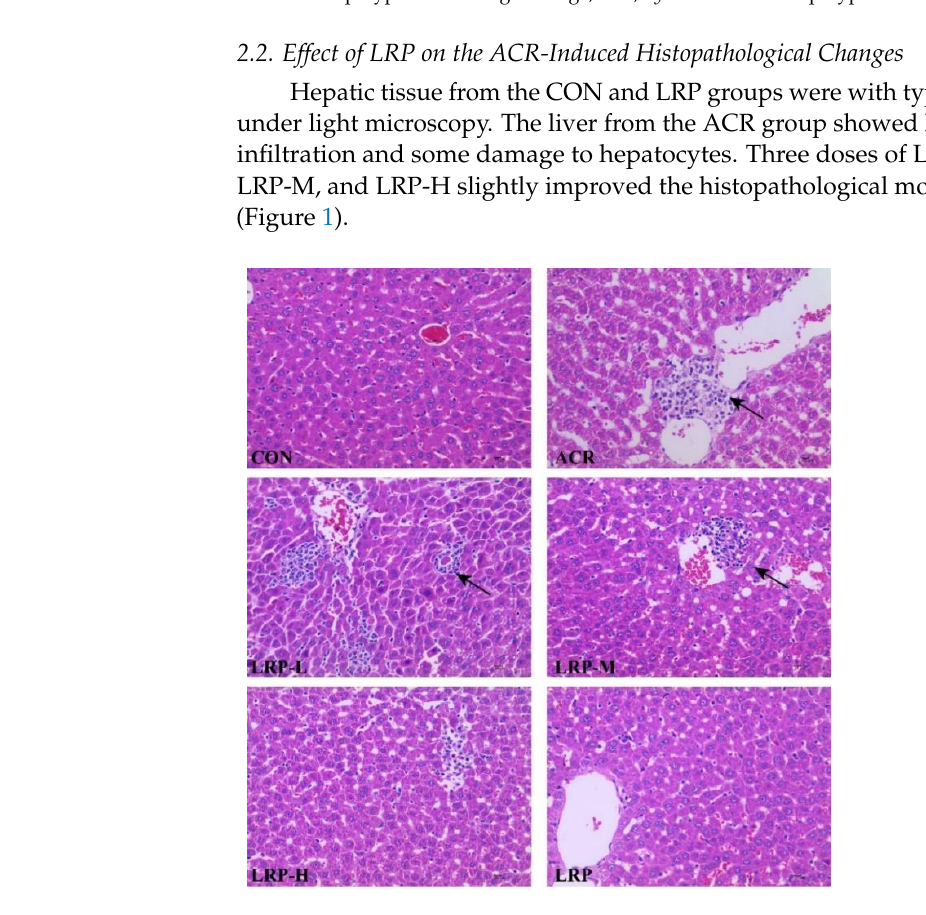
Figure 1. Effect of LRP on the ACR-induced histopathological changes (hematoxylin and eosin (H&E), 400×, bar 10 μm). The black arrow, inflammatory cell infiltration. ACR, acrylamide; LRP-L, Lycium ruthenicum polyphenols in low dosage; LRP-M, Lycium ruthenicum polyphenols in medium dosage; LRP-H, Lycium ruthenicum polyphenols in high dosage; LRP, Lycium ruthenicum polyphenols control group.